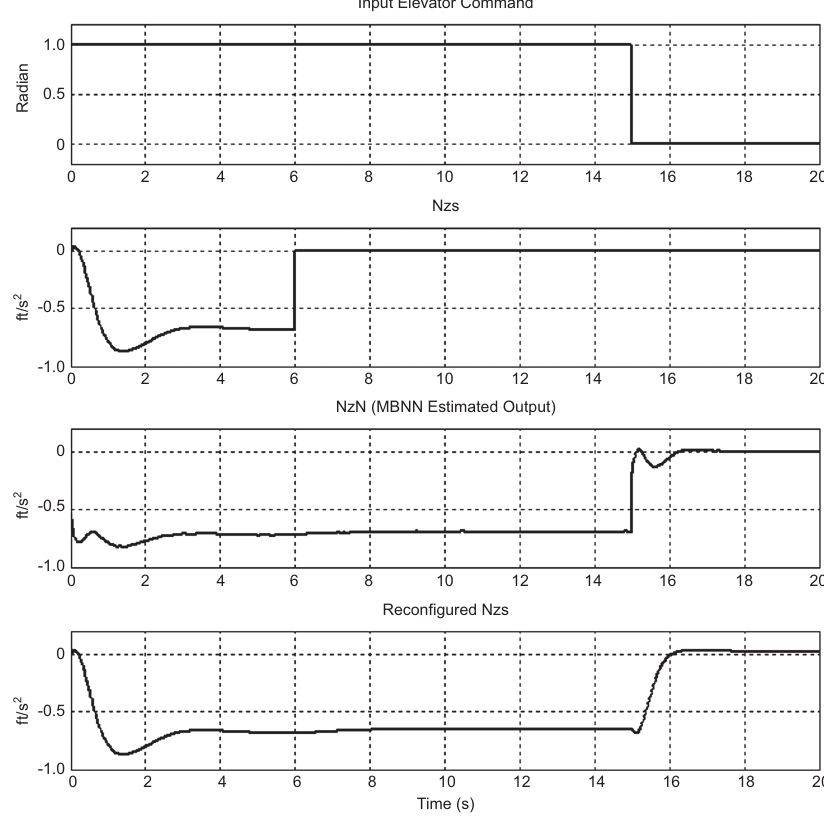
Figure 7. SFDA for Stuck Fault of “0” at 6